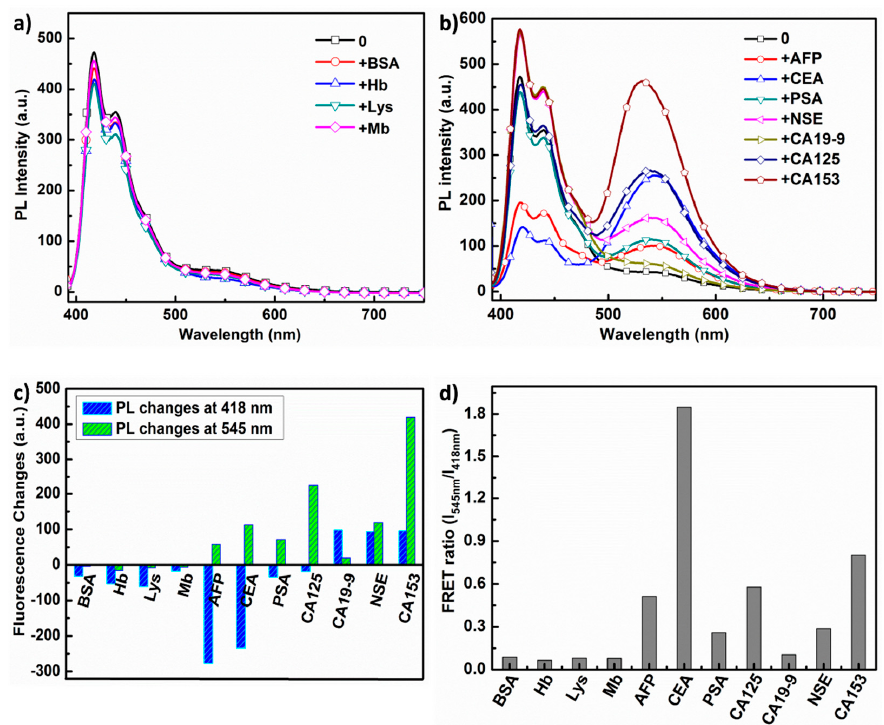
Figure 6. PL spectra of PFC3NBT in PBS (pH = 7.4) in the absence and presence of different proteins ( a ) for BSA, Hb, Lys and Mb; ( b ) for AFP, CEA, PSA, CA125, CA19-9, NSE and CA153. RU = 4.5 μ M, [protein] = 0.25 μ M or less. Excitation at 380 nm; ( c ) the changes of the fluorescence emission peaks at 418 ( ∆ I 418 nm ) and 545 nm ( ∆ I 545 nm ) as a function of proteins; ( d ) the FRET ratio of the green emission at 545 nm to the blue emission of PFC3NBT at 418 nm ( I 545 / I 418 ) as a function of